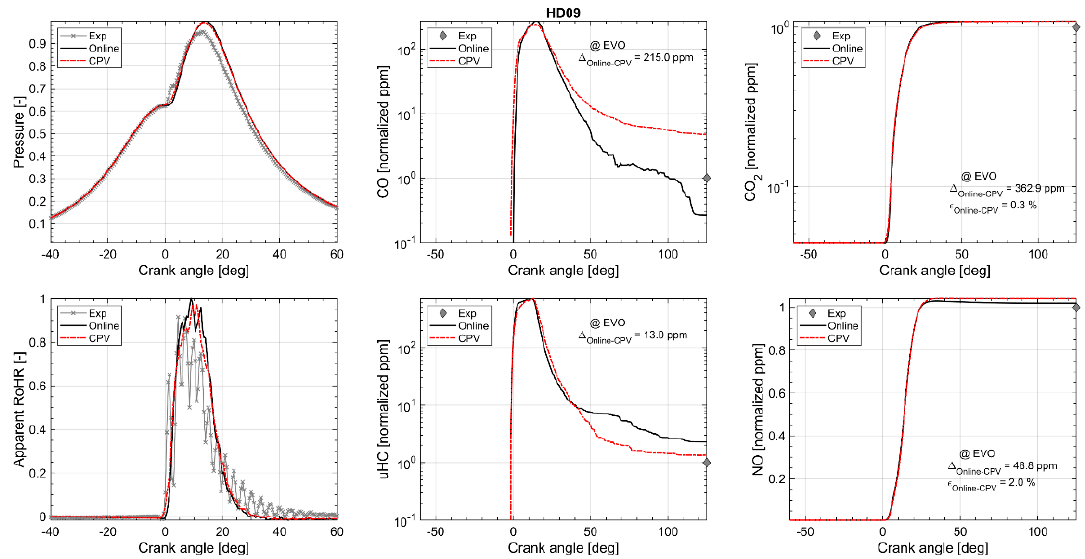
Figure A9. Engine performance and emissions for operating point HD09 (1000 rpm, 11.0 bar IMEP).